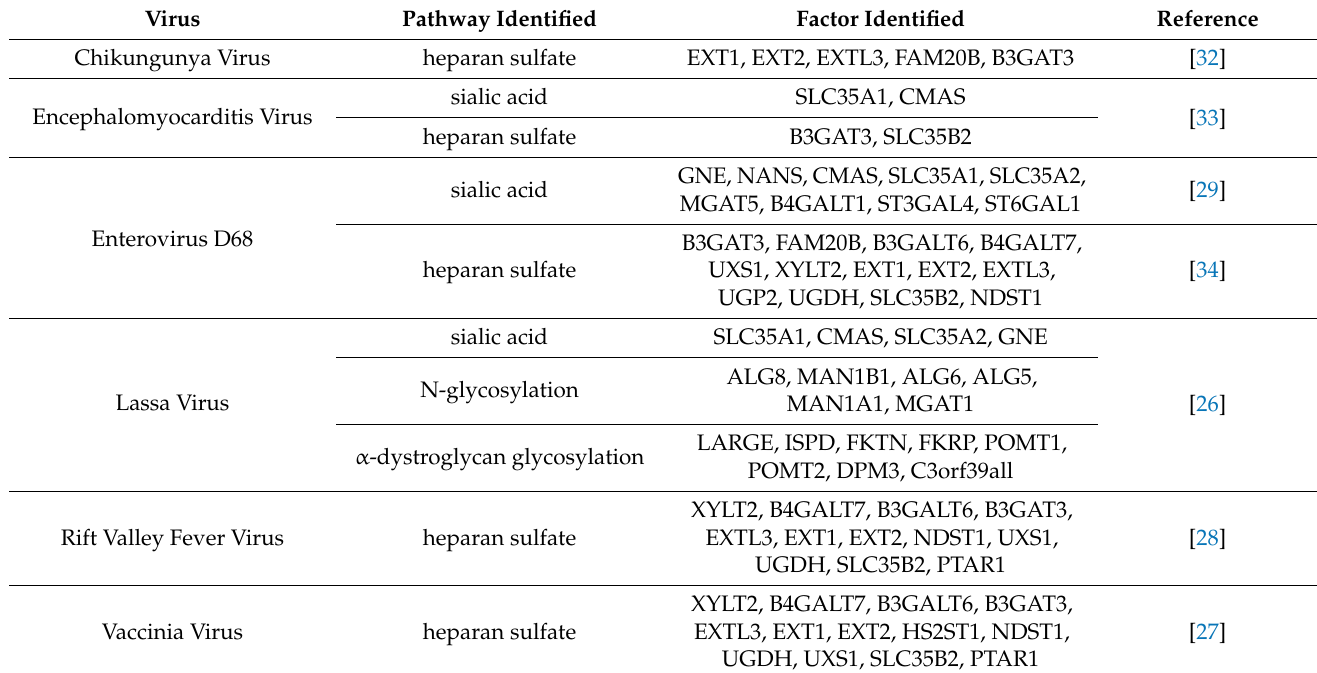
Table 1. Glycan biosynthetic pathways identified with haploid screening.